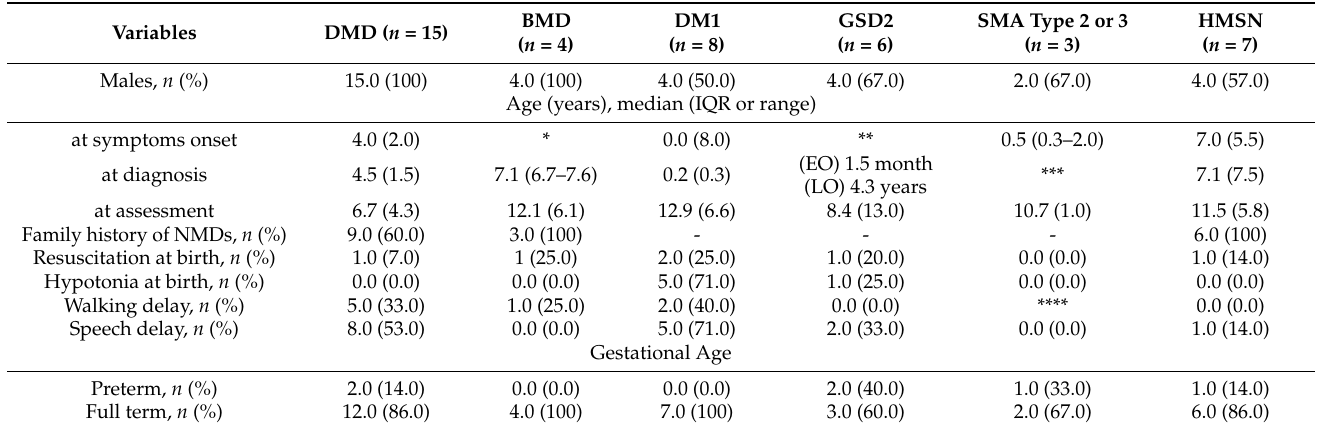
Table 1. Demographics and characteristics of the